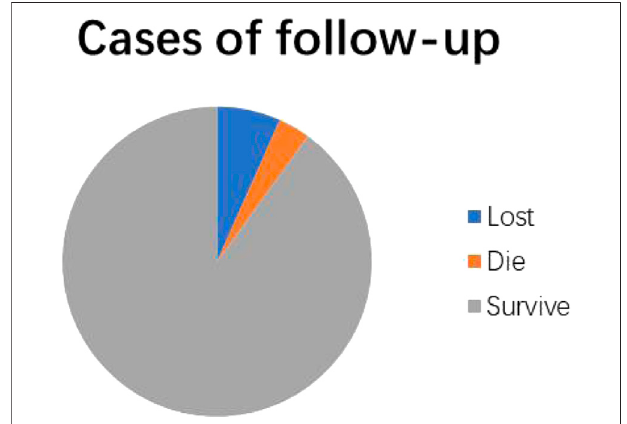
FIGURE 2 | Pie chart of statistics in follow-up record and prognosis